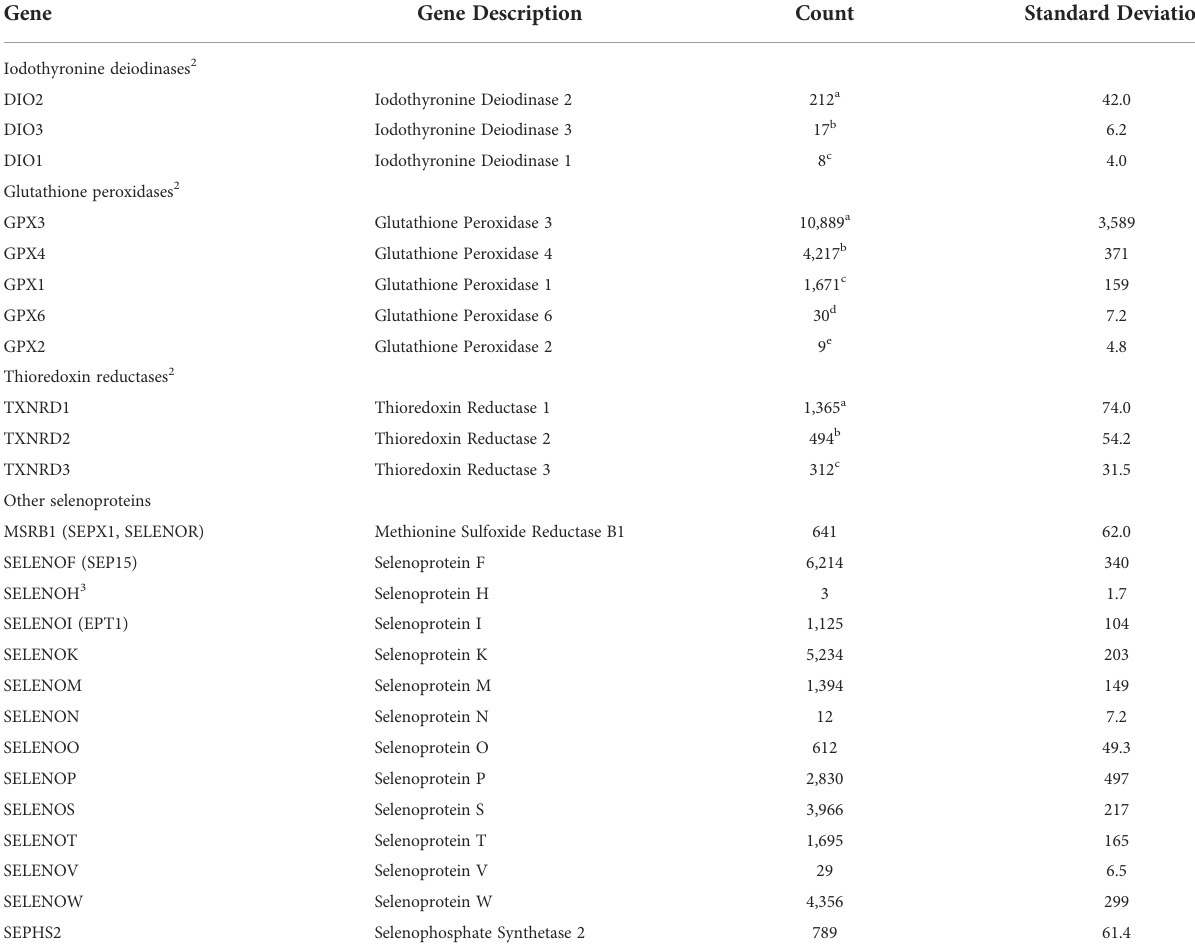
TABLE 2 NanoString analysis of bovine selenoprotein mRNA abundance (counts) in pituitary tissue of steers grazing high endophyte-infected forages and receiving inorganic supplemental selenium 1 . Gene Gene